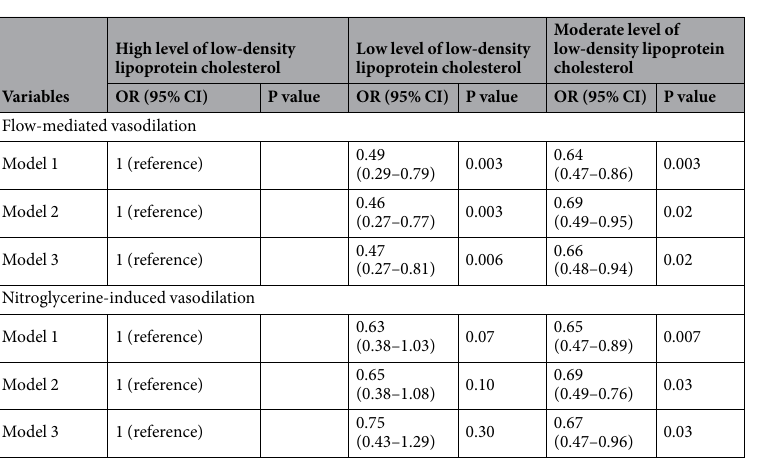
Table 3. Multivariate Analysis of the Relations between Vascular Dysfunction and Low-Density Lipoprotein Cholesterol. Low tertile of flow-mediated vasodilation indicates less than 2.7%. Low tertile of nitroglycerine- induced vasodilation indicates less than 10.6%. Model 1: unadjusted model. Model 2: adjusted for age, gender. Model 3: adjusted for age, gender, body mass index, current smoking, presence of hypertension and diabetes